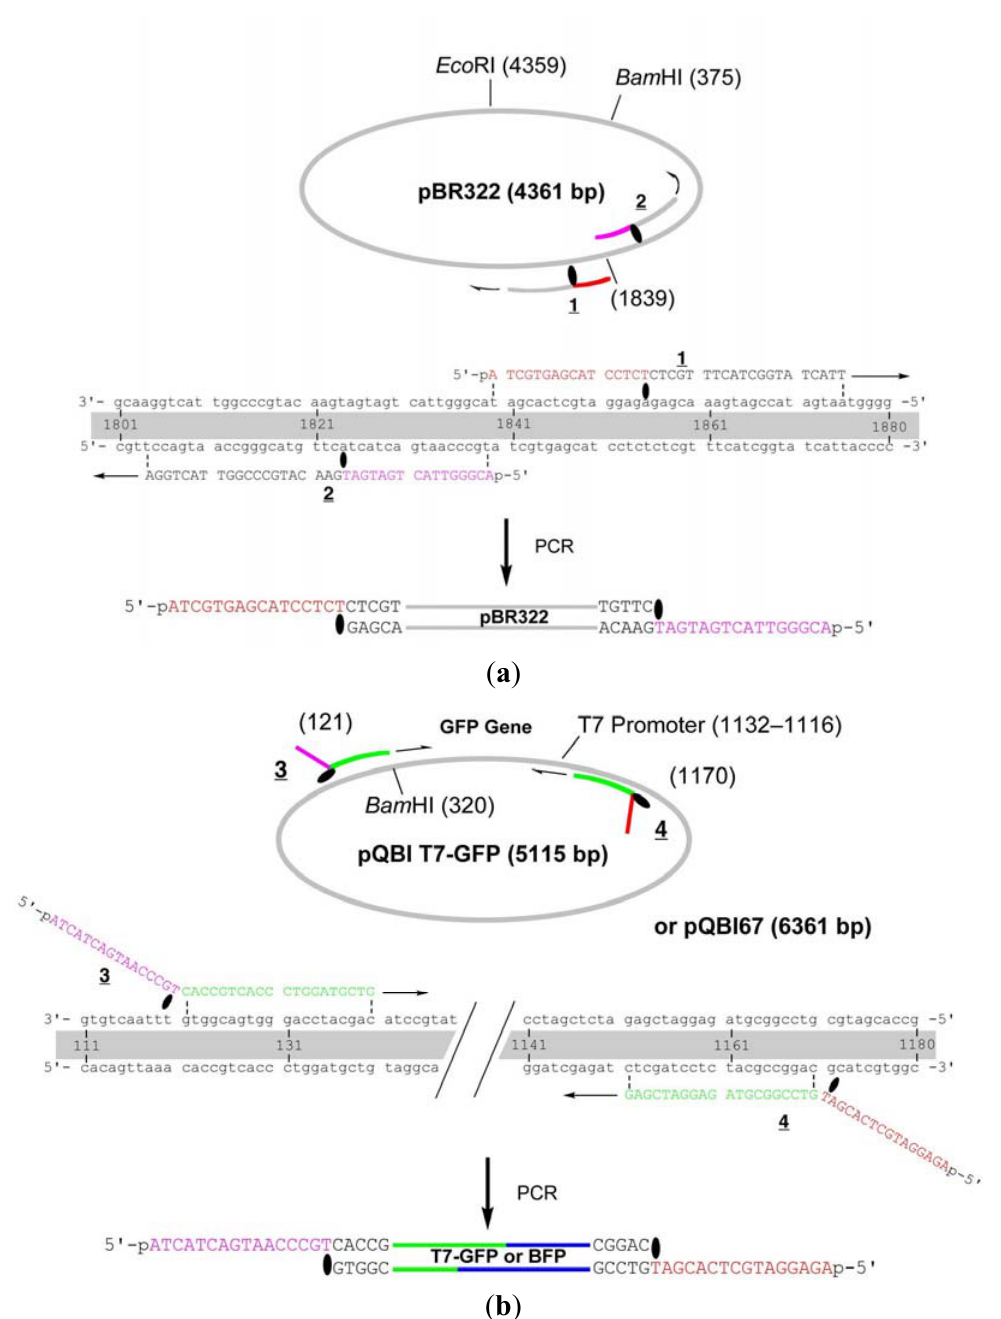
Figure 1. Detailed structure of the primers for the construction of GFP-